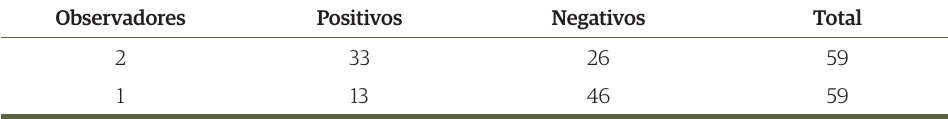
Tabela 3. Sensibilidade do teste parasitológico em relação ao número de observadores, Uberlândia, 2010.